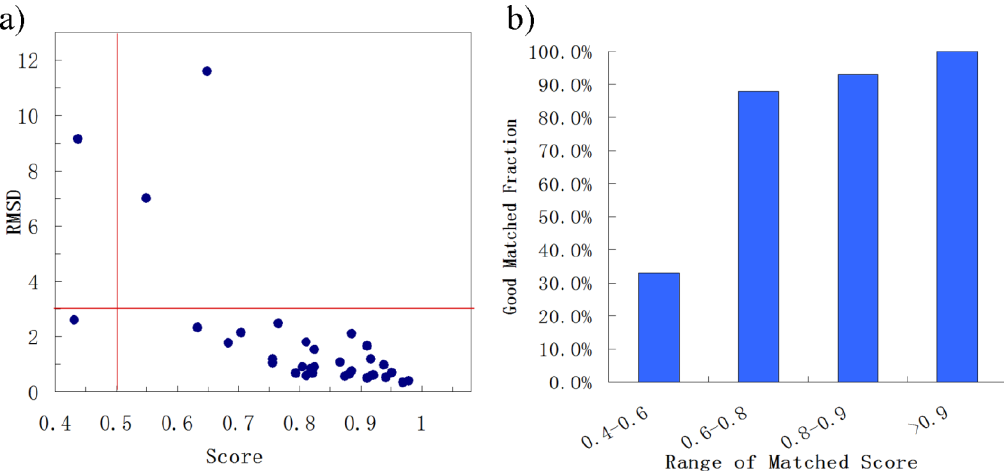
Figure 2. The summary of the matched results of BSMM for data set A: given the good matching should be RMSD < 3.0 Å , the rate of good matching for data set A is 91% (30/33); carefully checking the pairs which the matched RMSD is > 3.0 Å found the binding sites of the pairs matched well, and the high RMSD due to the different binding mode of the ligands. ( a ) the correlation between the ligand RMSD and the the matched score; ( b ) the good matching rate in different range of matched score.